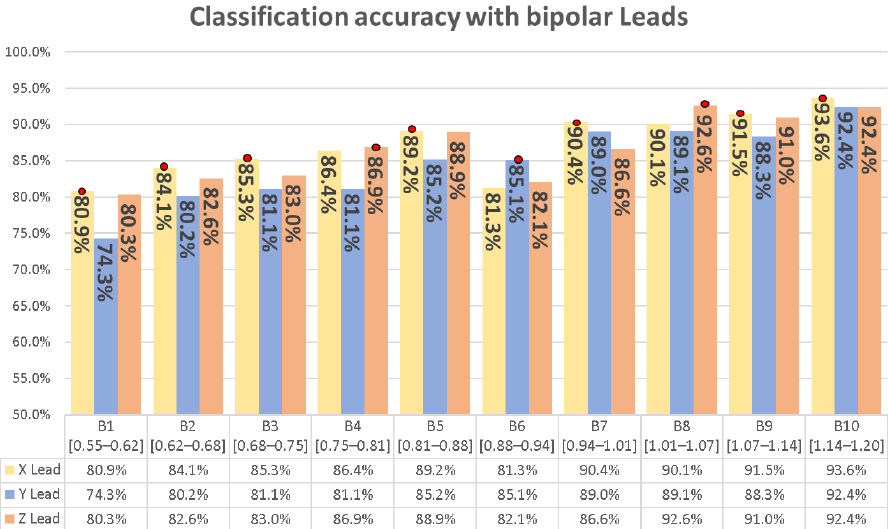
Figure 7. Single lead accuracy results. ( • means maximum value per